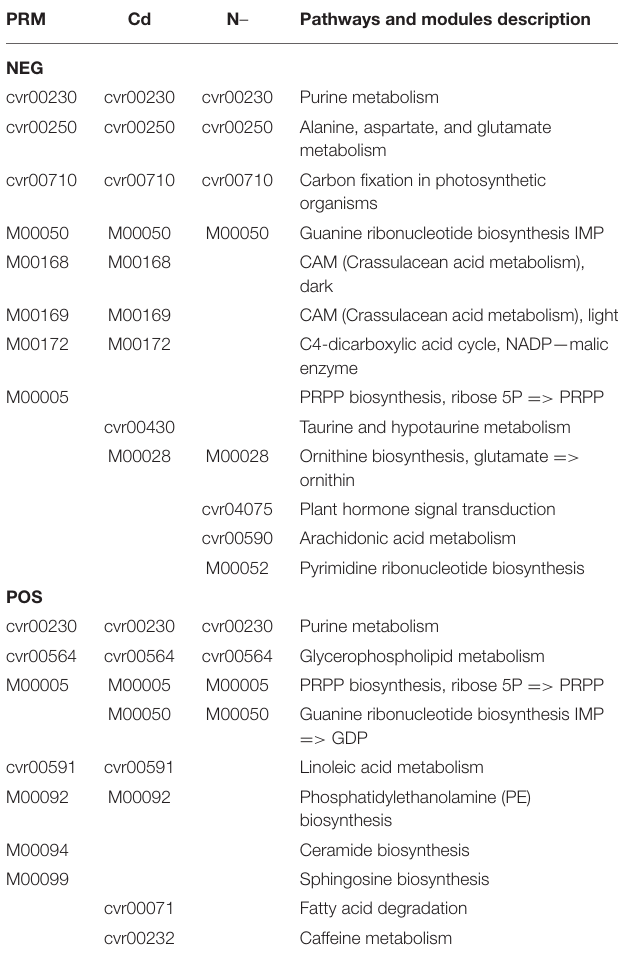
TABLE 3 | Network plots of significantly enriched pathways and modules under